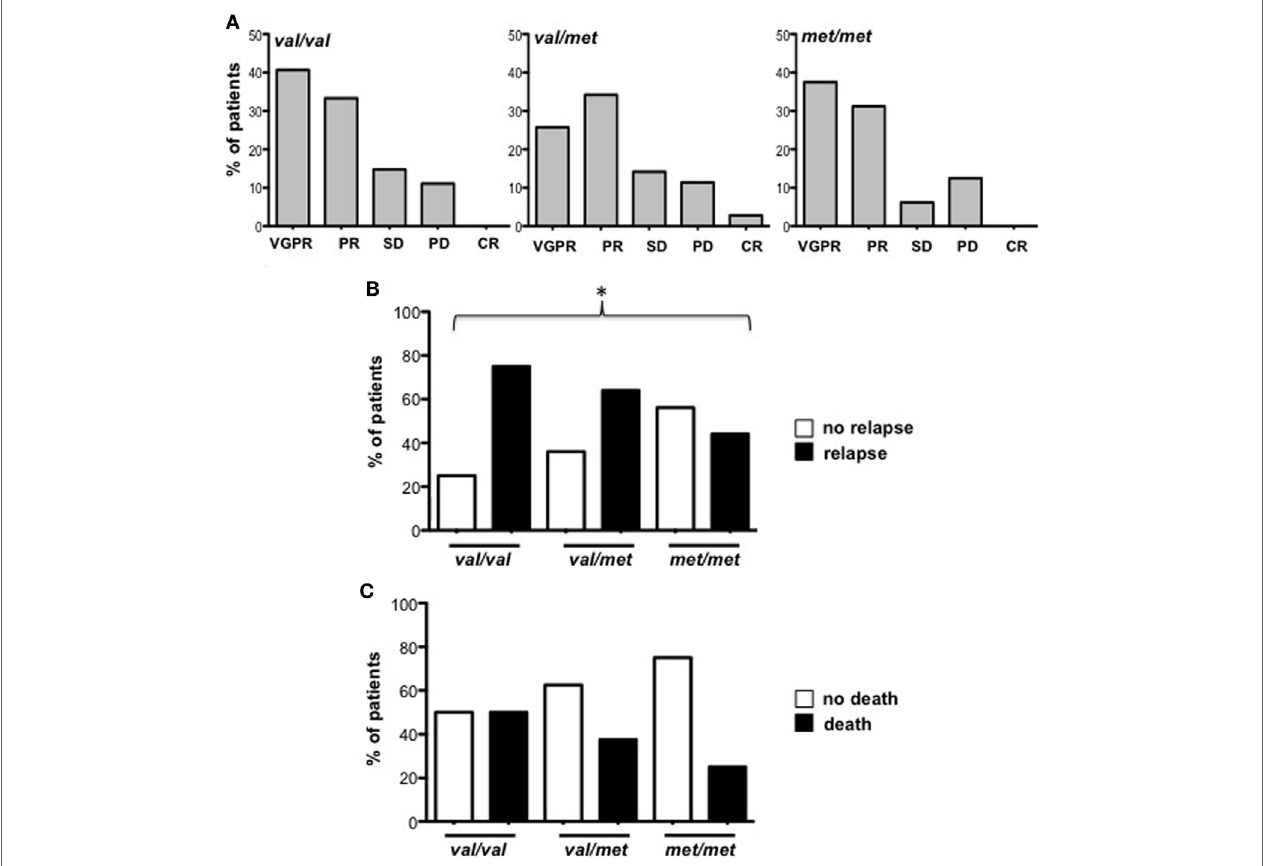
FigUre 2 | Patient outcome related to MICA-129 genotype. (a) Response to therapeutic treatment of multiple myeloma (MM) patients (Onset and Relapse). VGPR, very good partial response; PR, partial response; SD, stable disease; PD, partial disease, CR, complete remission. (B) Frequency of relapse development in MM patients after chemotherapy. χ 2 test, p = 0.0413. (c) Frequency of deceased patients in MM patients after chemotherapy. Total patients, n = 74; Val/Val, n = 26; Val/Met, n = 32; Met/Met, n = 16. Abbreviations: Val, valine; Met,